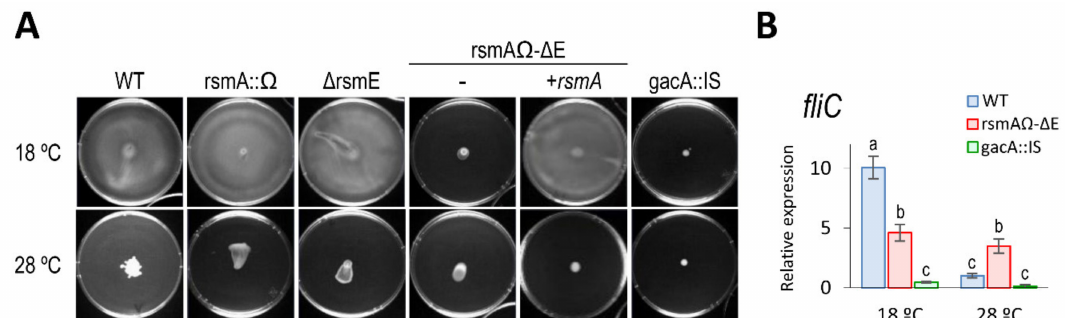
Figure 7. Swarming motility is thermoregulated and redundantly dependent on RsmA and RsmE in P. amygdali pv. phaseolicola 1448A. ( A ) Essay of motility at di ff erent temperatures. Strains were grown on the surface of peptone-glucose agar (0.5 %) for 48 h. Similar results were obtained for strain rsmA Ω - ∆ E complemented with rsmA or with rsmE . Pictures are representative of three replicates in three independent experiments. ( B ) Relative expression of the flagellin gene, fliC , assessed by quantitative real-time reverse transcription PCR (RT-qPCR). Bars represent the average expression relative to strain 1448A (WT) at 28 ◦ C, after normalization with gene gyrA as an internal control. Letters above bars denote ANOVA categories with significant di ff erences ( p < 0.05). Error bars correspond to the standard deviation of three biological